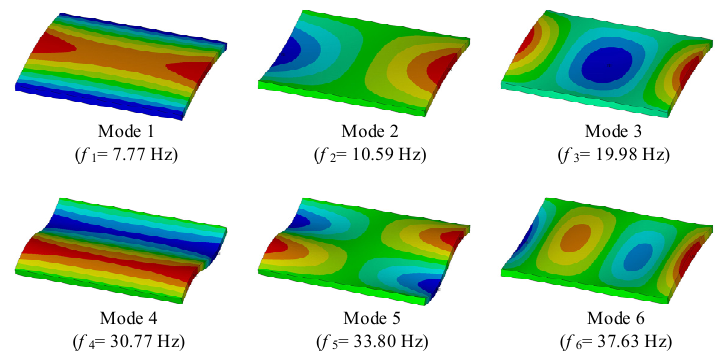
Figure 4. The model of a hollow slab bridge: ( a ) finite element model ; ( b ) equivalent orthotropic plate model.